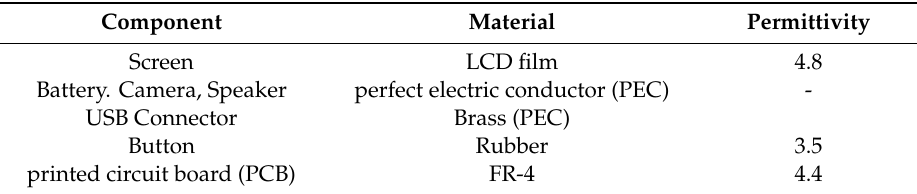
Table 3. Characteristics of the smartphone components.